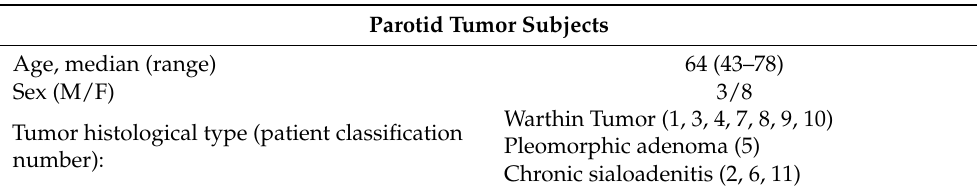
Table 3. Demographic and clinical data of the